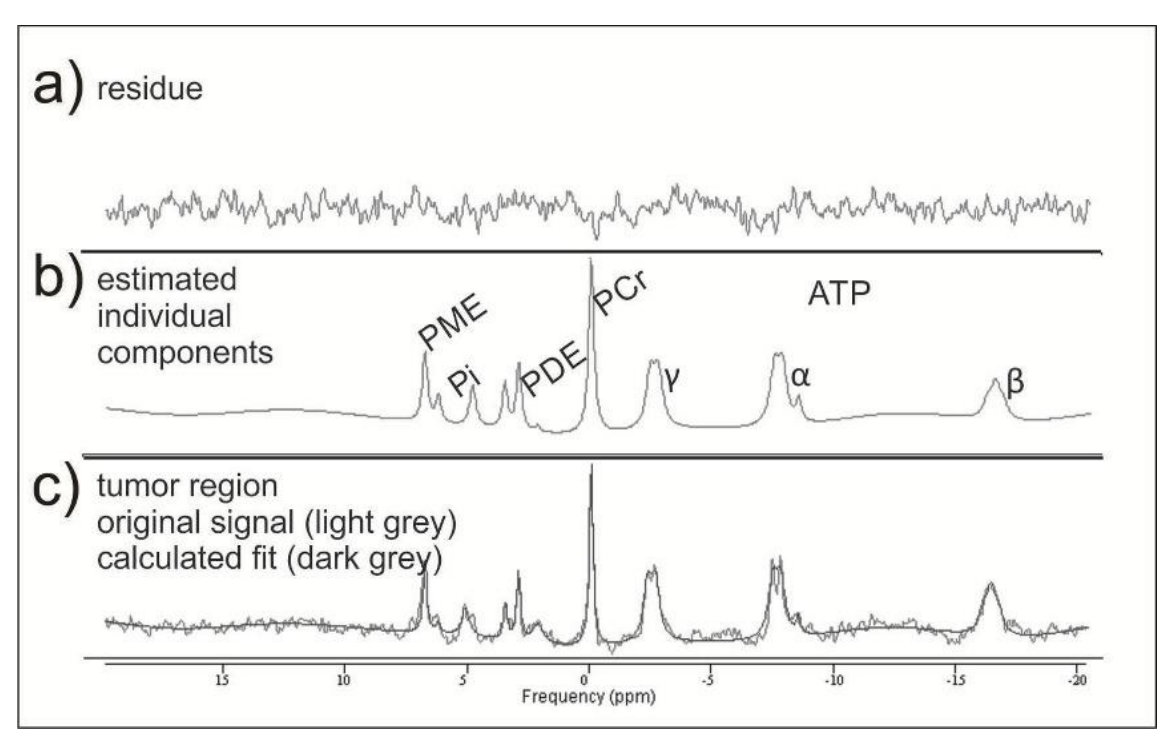
Figure 2. Example of two mathematically fitted 31P-MRS tumor spectra. In the middle row ( b ), there are the estimated individual metabolites with the corresponding residue ( a ) resulting from the mathematical fit. In the lower row ( c ), they are both together.